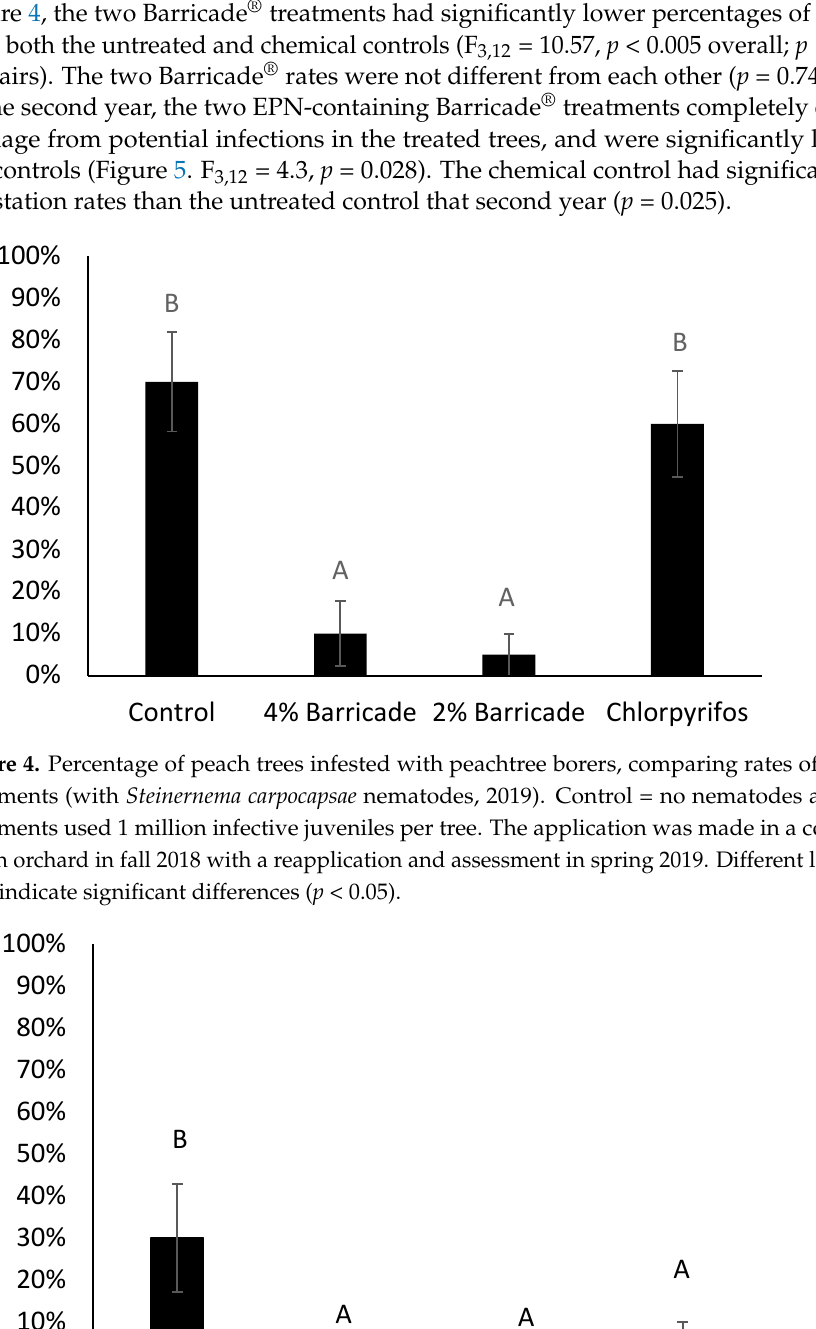
icant differences ( p < 0.05).